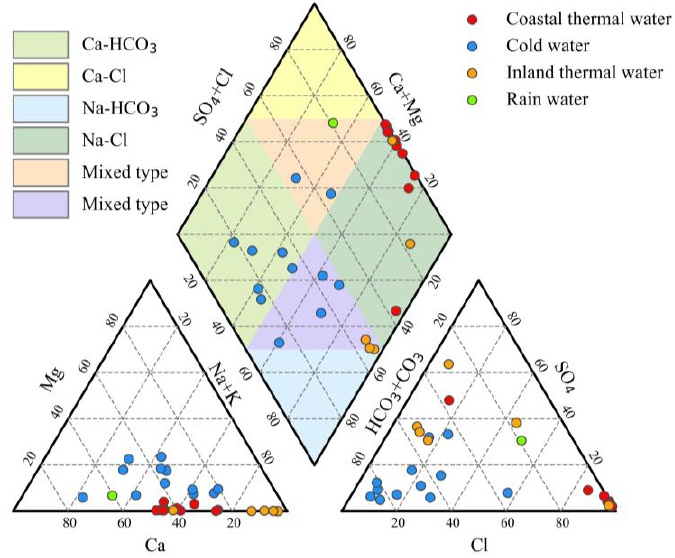
Figure 2. Piper diagram of different water bodies in southeastern China.